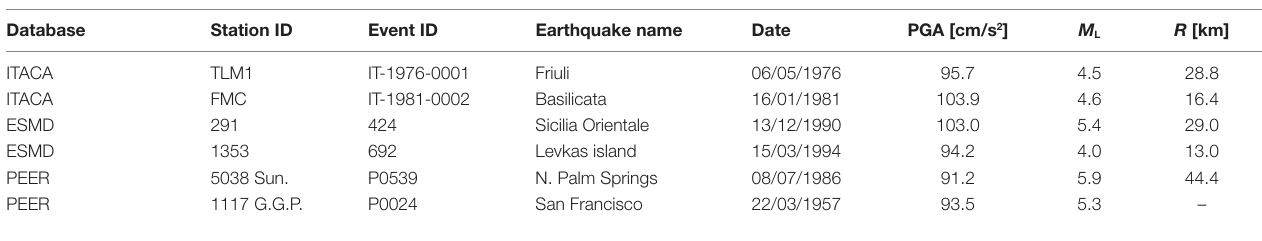
TaBle 2 | six ground motion records from the three